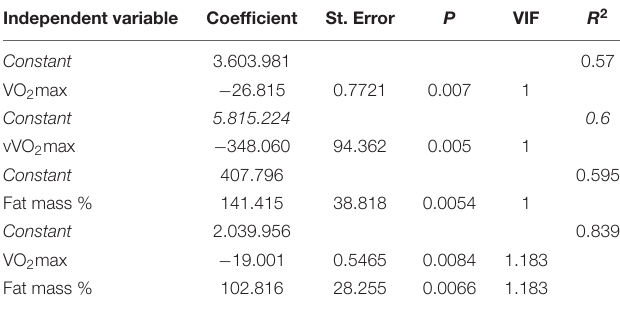
TABLE 5 | Model summary resulting from stepwise multiple regression analysis.